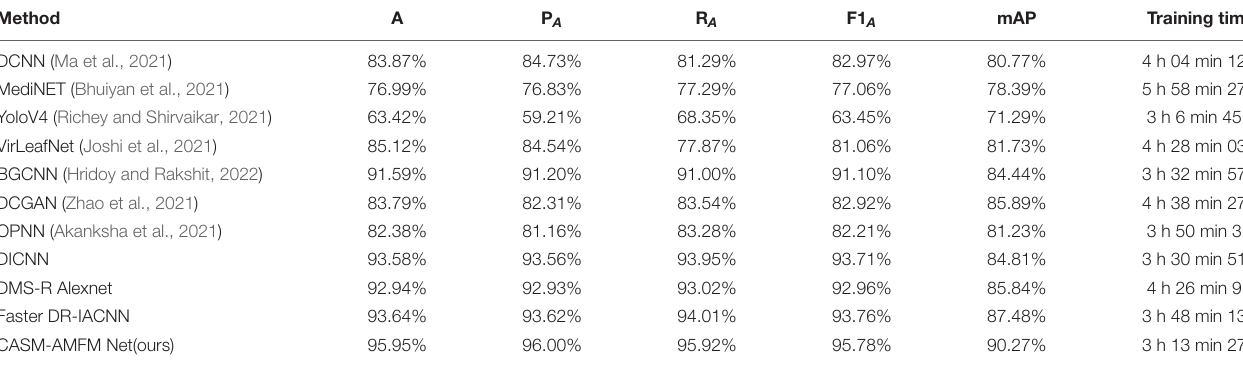
TABLE 13 | Comparison of the main performance of different